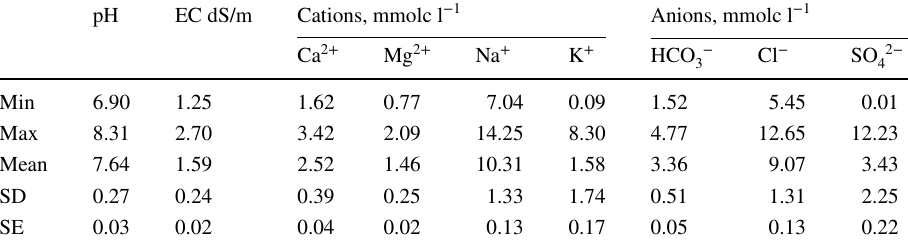
of the Bahr El-Baqr drain